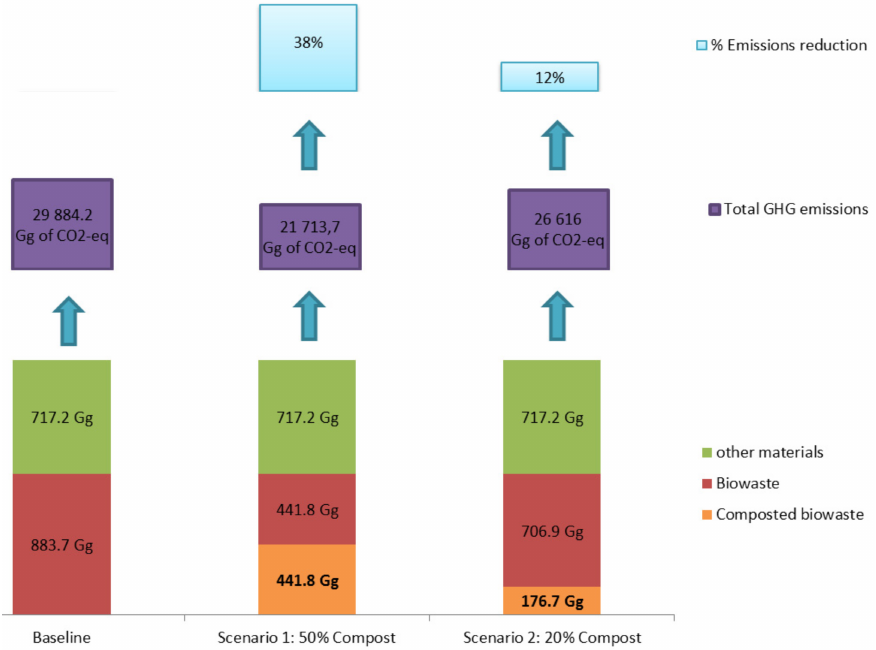
Figure 2. GHG emissions reduction by implementing composting facilities for MSW treatment